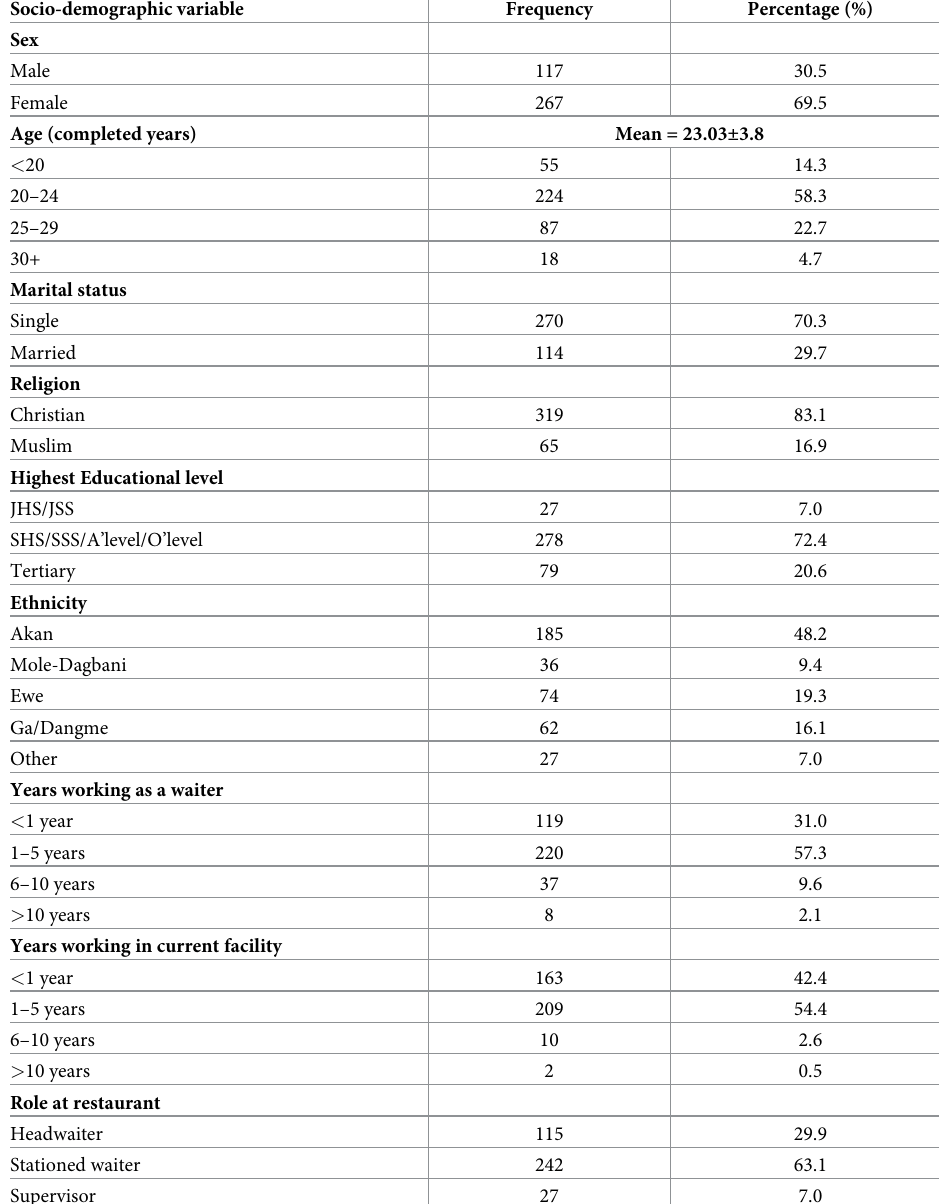
Table 1. Socio-demographic characteristics of